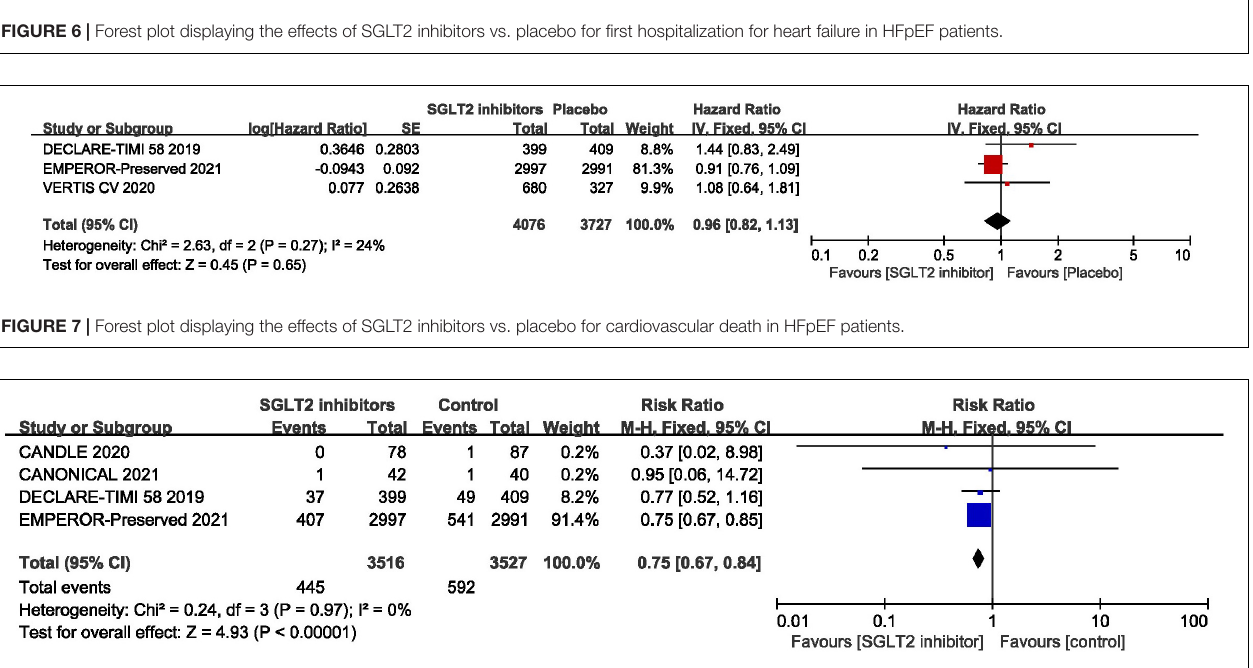
FIGURE 8 | Forest plot displaying the effects of SGLT2 inhibitors vs. placebo for total hospitalization for heart failure in HFpEF patients.